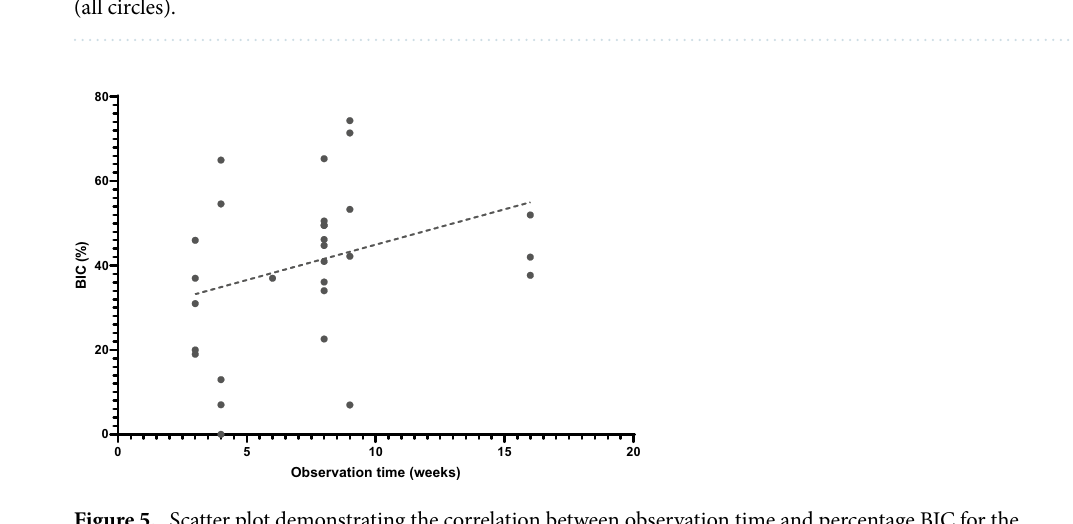
Figure 5. Scatter plot demonstrating the correlation between observation time and percentage BIC for the animal studies. Spearman’s ρ = 0.40, p value = 0.01.